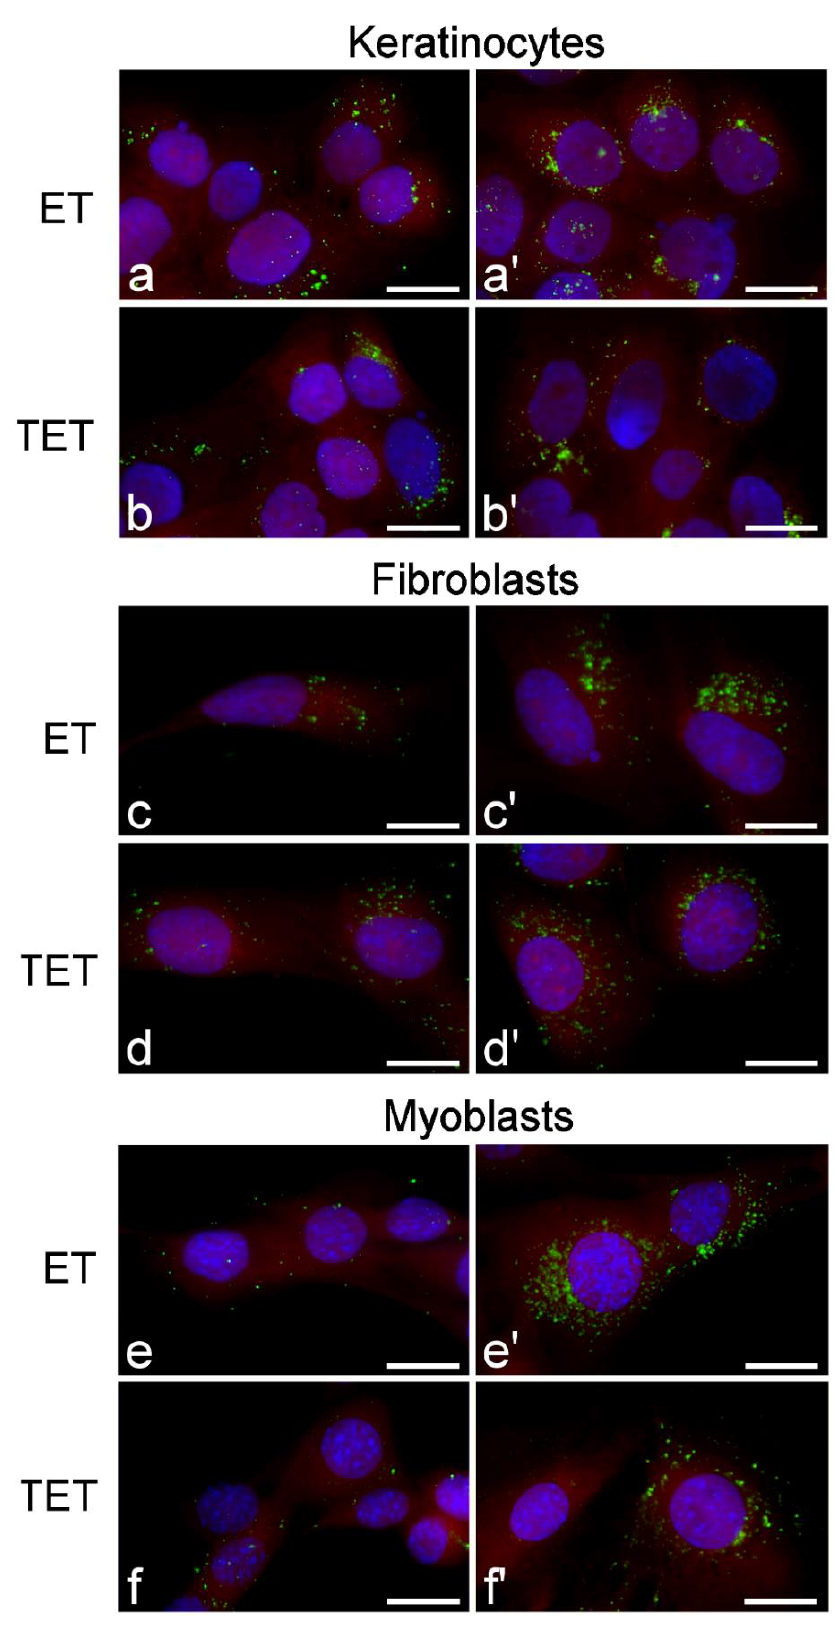
Figure 5. Fluorescence micrographs of keratinocytes, fibroblasts and myoblasts after 2 h ( a – f ) and 24 h ( a’ – f’ ) incubation with ET or TET. Nanocarriers in green (PKH67), cytoplasm in red (trypan blue) and nucleus in blue (Hoechst 33342). Bars 20 μm.